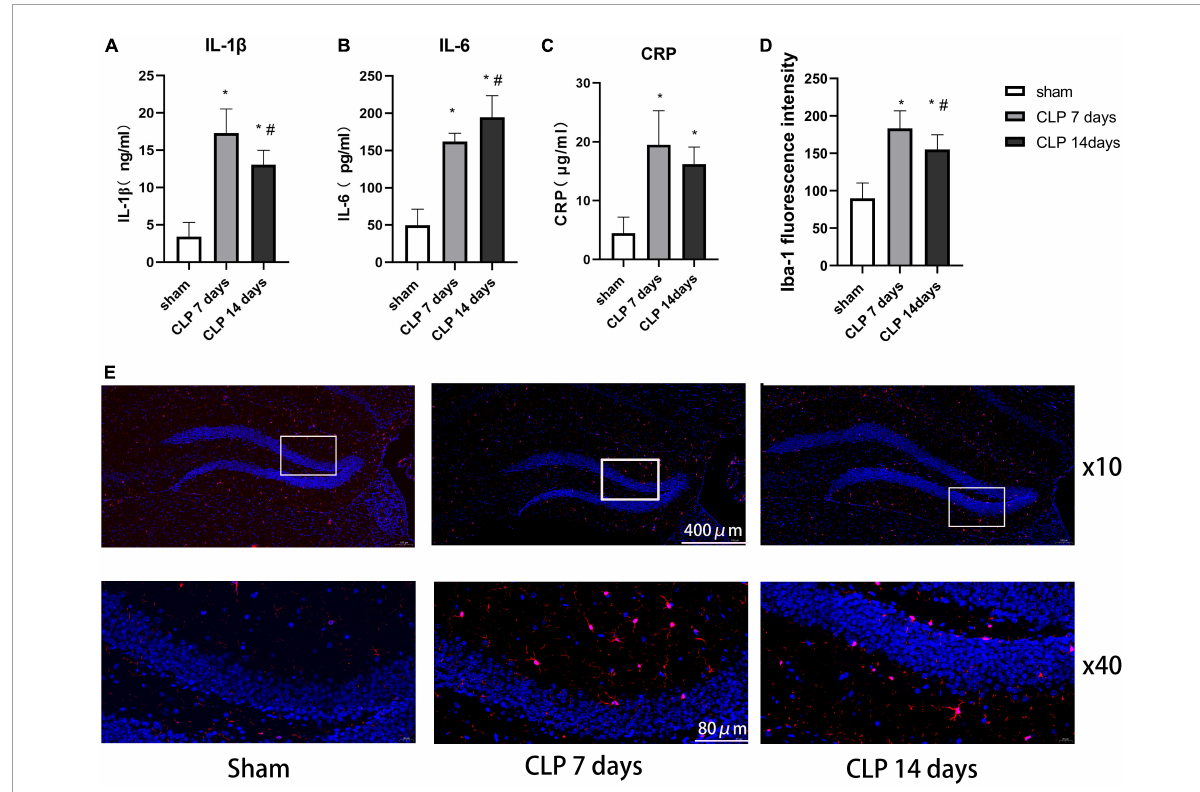
FIGURE4 Cecal ligation and perforation surgery enhanced microglia related inflammation in hippocampus of SAE rats. The difference in panel (A) IL-1 β , (B) IL-6, and (C) CRP levels in hippocampus among the three groups. (D) The intensity of Iba-1 in the hippocampus detected by immunofluorescence staining (* p < 0.05, compared with the sham group, # p < 0.05, compared with day 7 CLP group, analyzed by one-way ANOVA, n = 8). Data are expressed as the mean ± SD. (E) Representative immunofluorescence staining of Iba-1 (red) in the hippocampus, n = 8 per